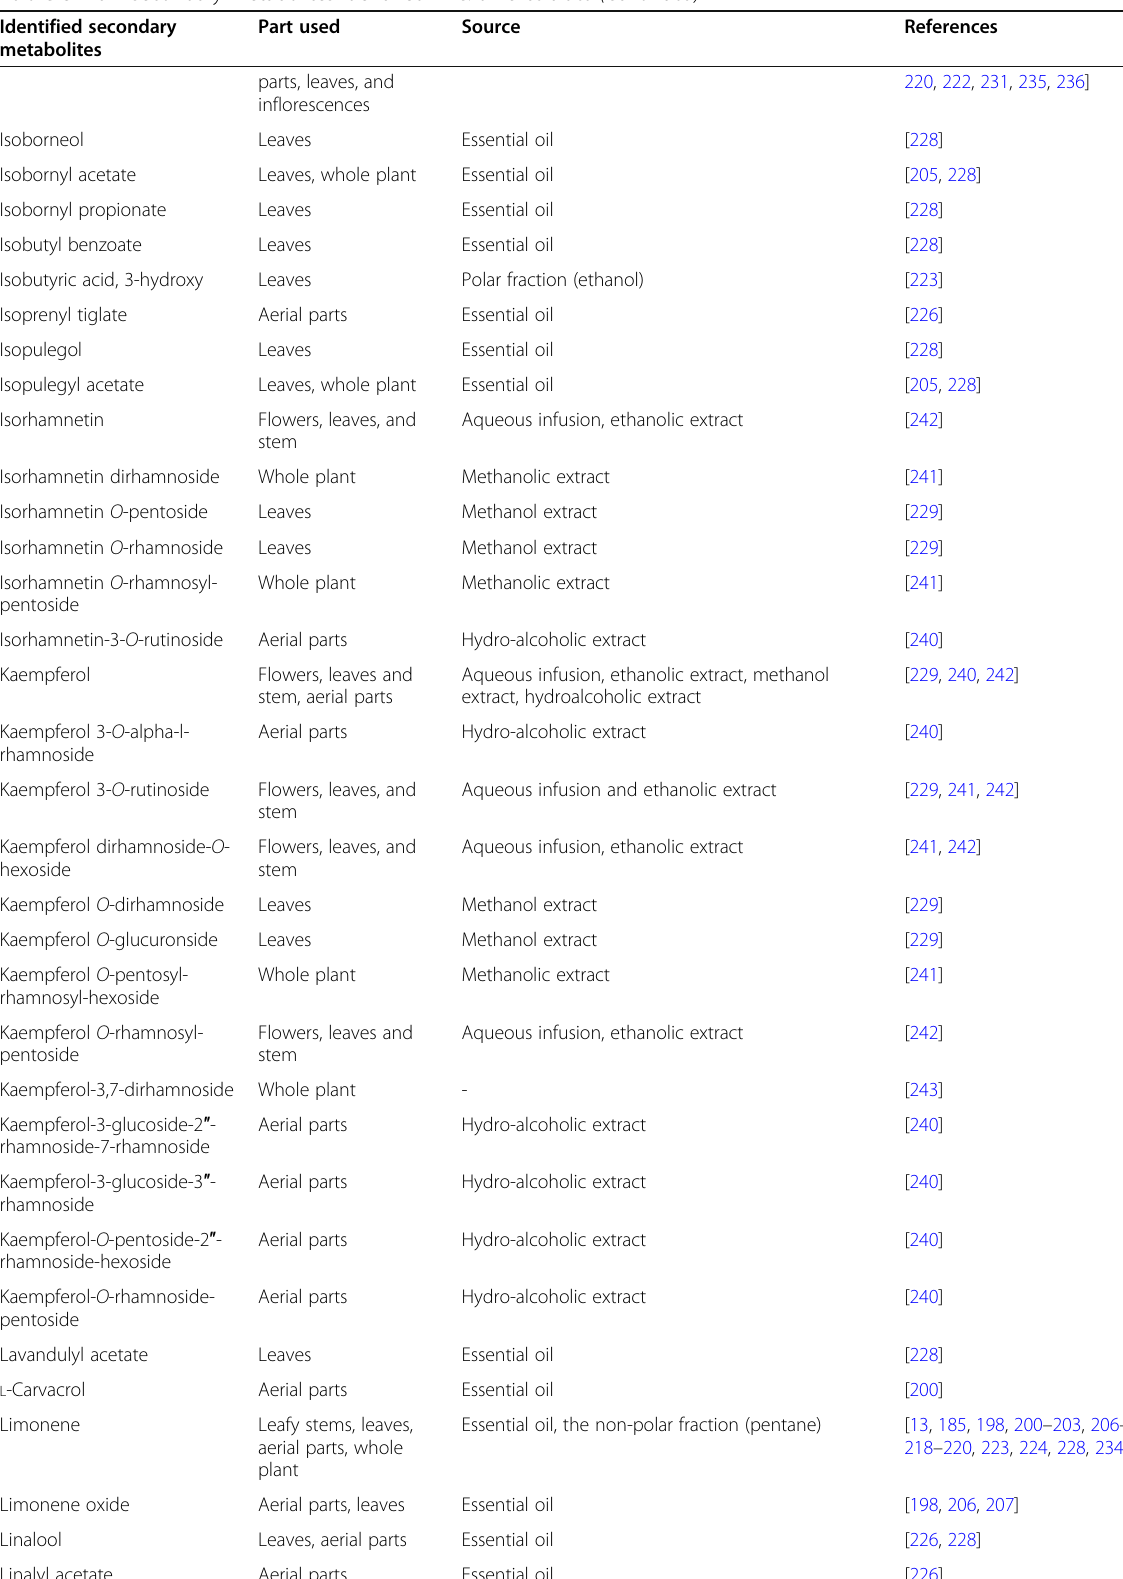
Table 3 Main secondary metabolites identified in C. ambrosioides